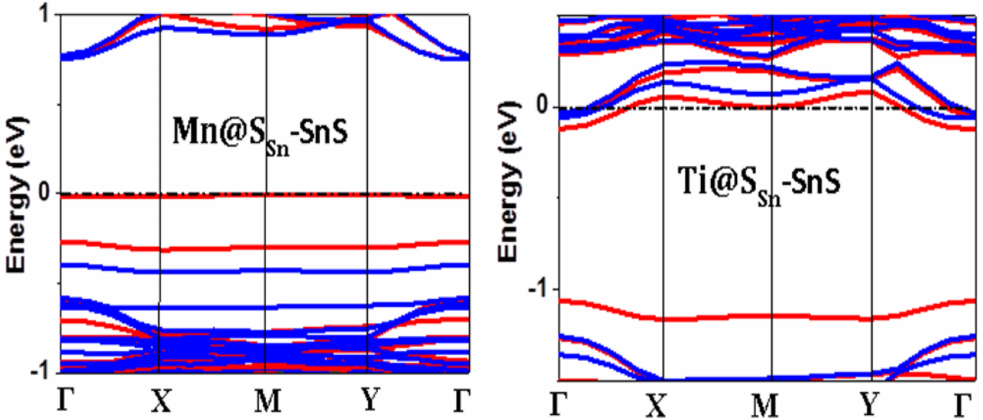
Figure 5. Band Structures of Mn-doped SnS and Ti-doped SnS with GGA + U calculations, where Γ -X-M- Υ - Γ means the high symmetric points in Brillouin